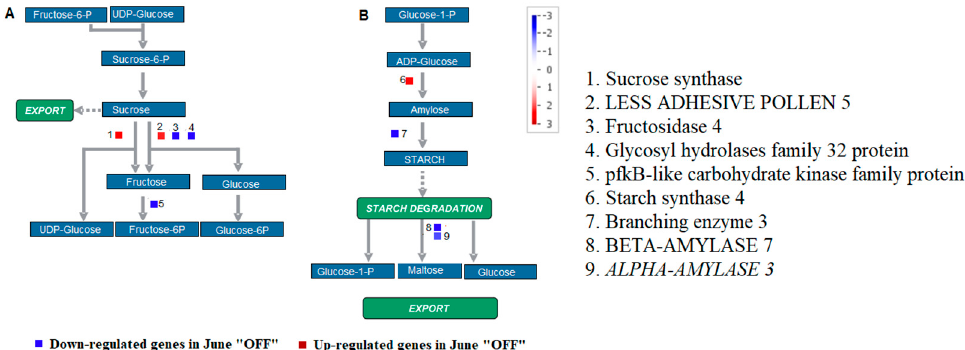
differentially expressed genes between inflorescence buds in the non-bearing shoot (June “OFF”) and inflorescence buds in bearing shoot (June “ON”) in sucrose degradation ( A ) and starch synthesis ( B ) pathways. Individual genes were represented by small squares. The color scale indicates the log2 FC value. Red represents up-regulation and blue represents down-regulation in June “OFF” relative to June “ON”.